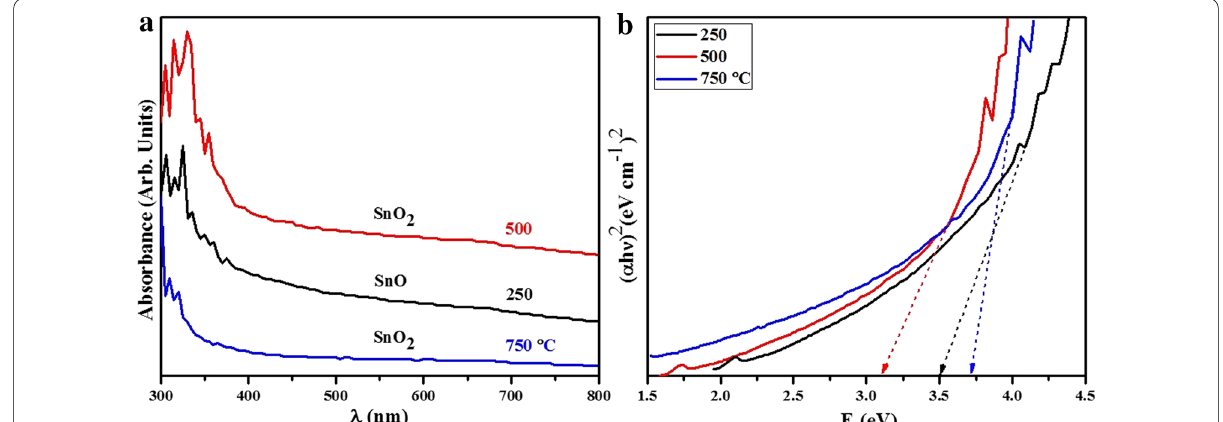
Fig. 8 a UV–Vis absorbance spectra and b energy gap values obtained from samples annealed at 250, 500 and 750 °C,